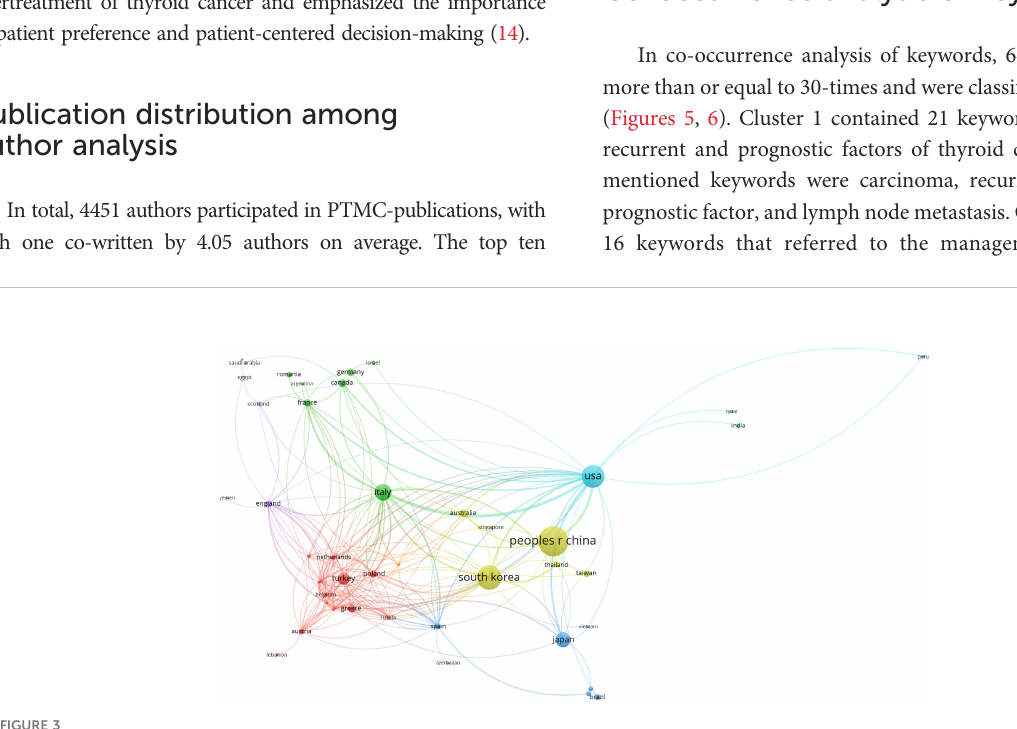
FIGURE 3 The international collaboration relationship networks. Bar length re fl ects the numerical size of each parameter. Dots represent country and larger dots indicate a larger number of publications of country. The clusters are labeled using different colors and the links represent citations or co-authorships of country,